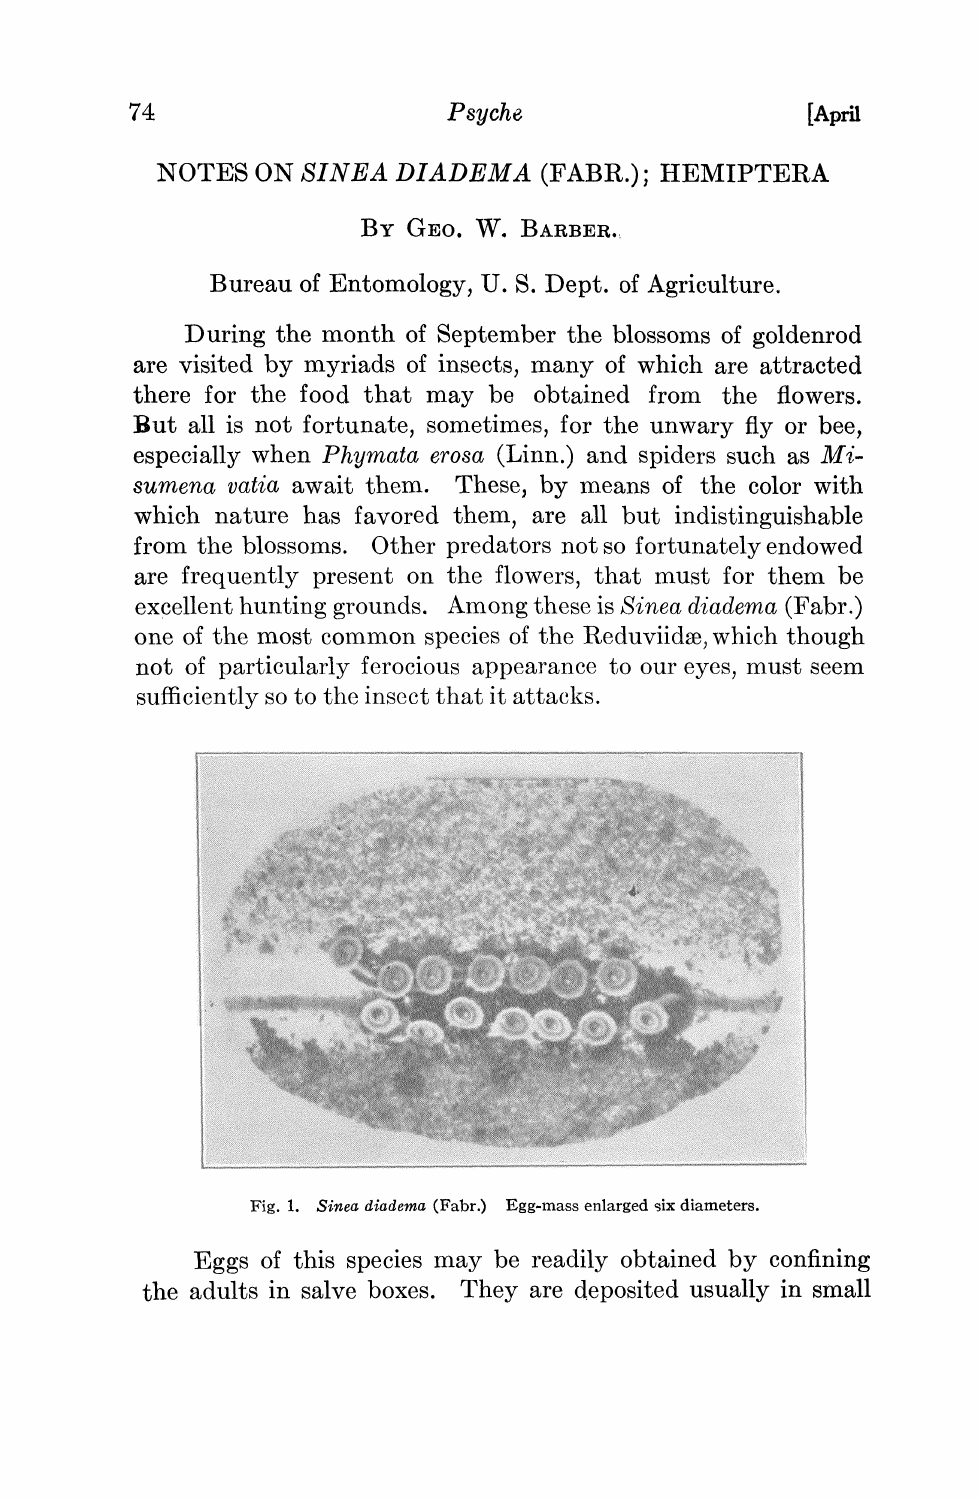
Fig. 1. Sinea diadema (Fabr.) Egg-mass enlarged six